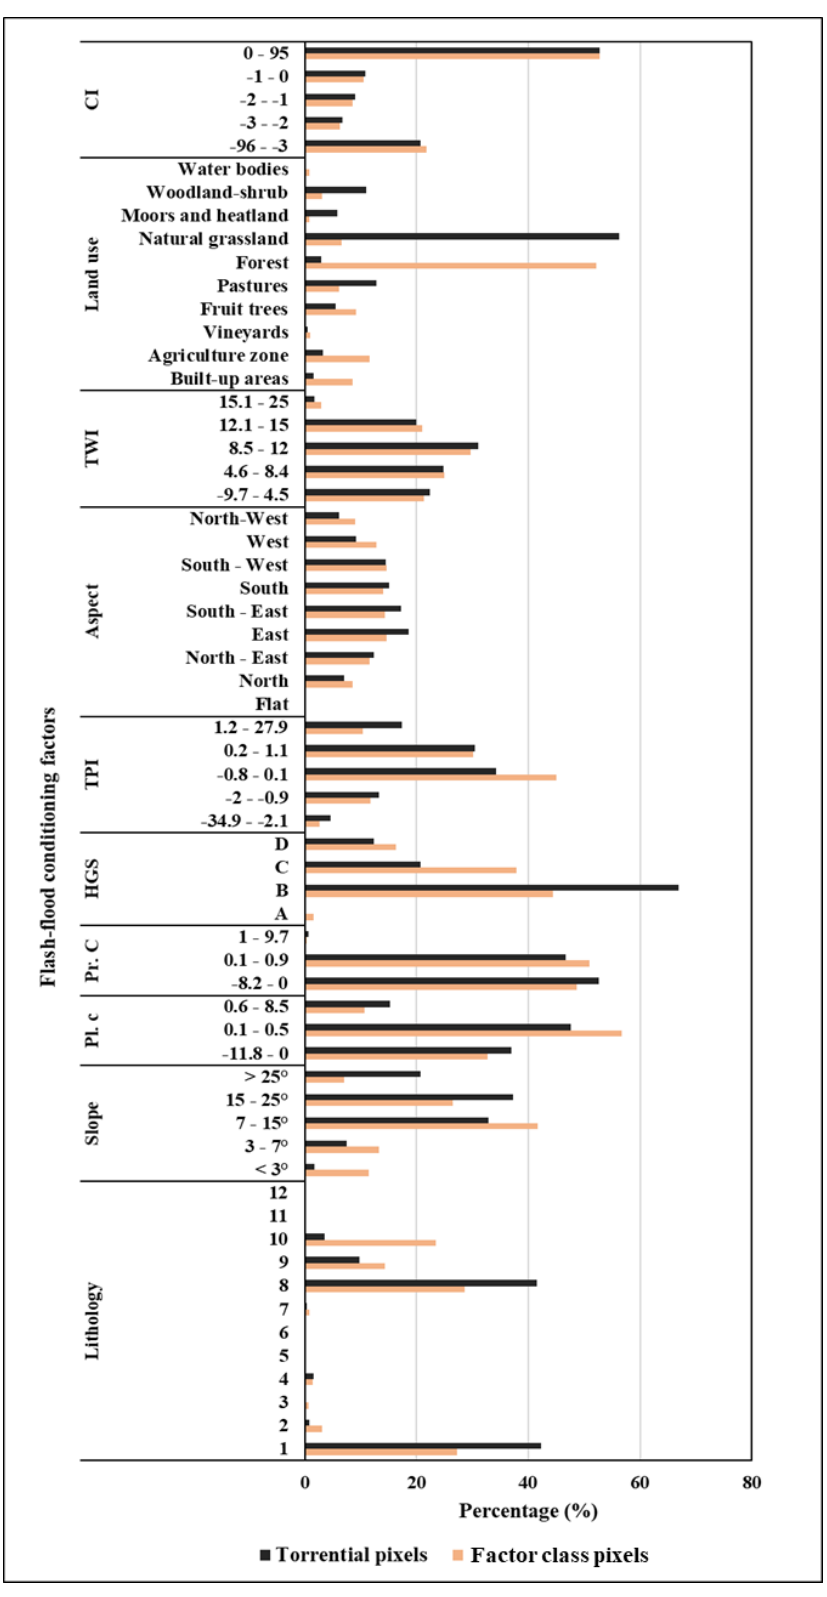
Figure 6. Relative frequency distribution of torrential phenomena pixels within flash-flood predictors classes/category.